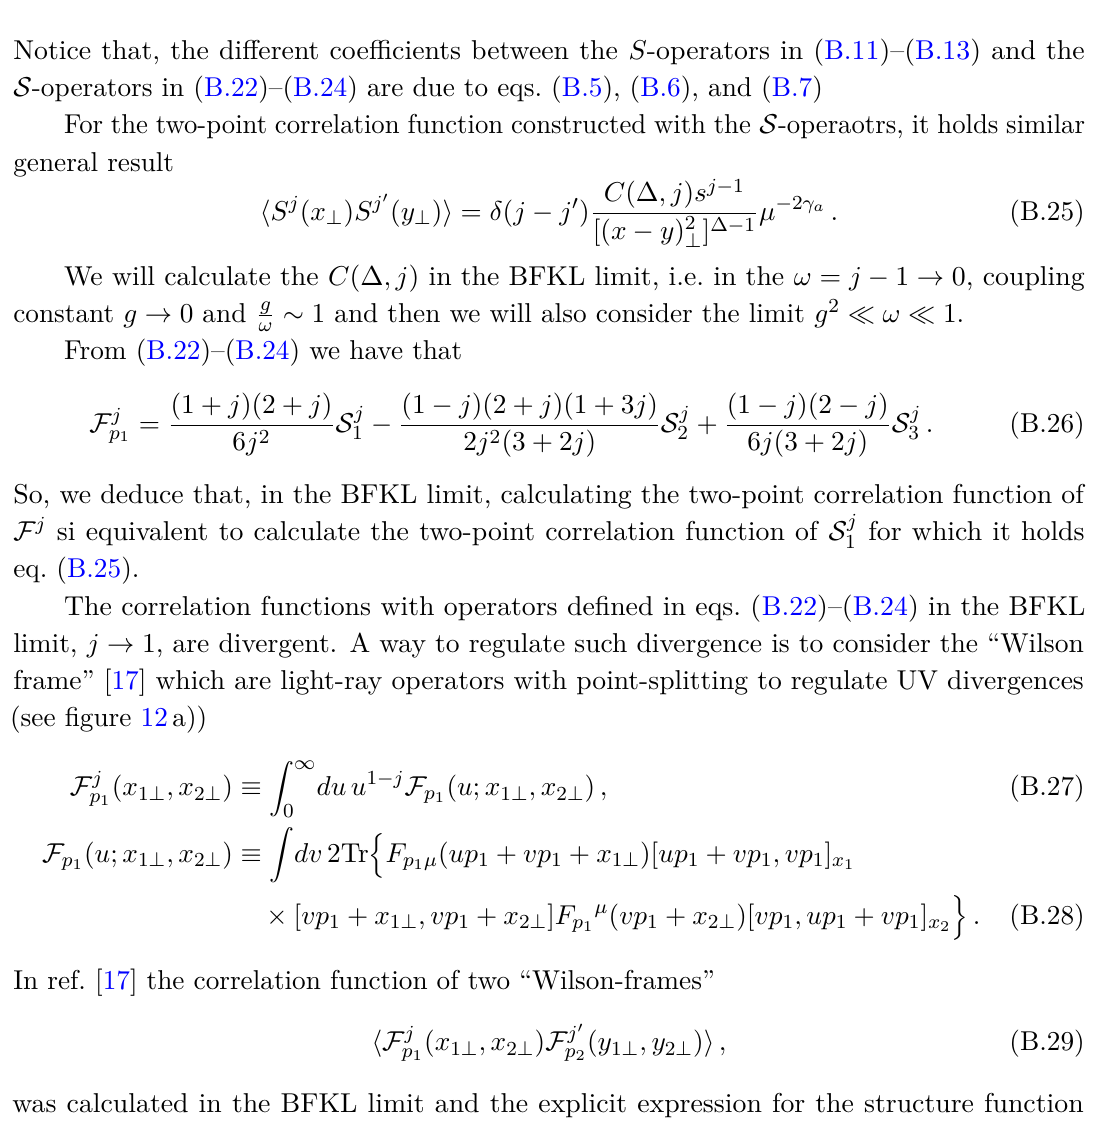
Figure 12 . In the left panel the Wilson frame is depicted, while in the right panel the quasi-pdf